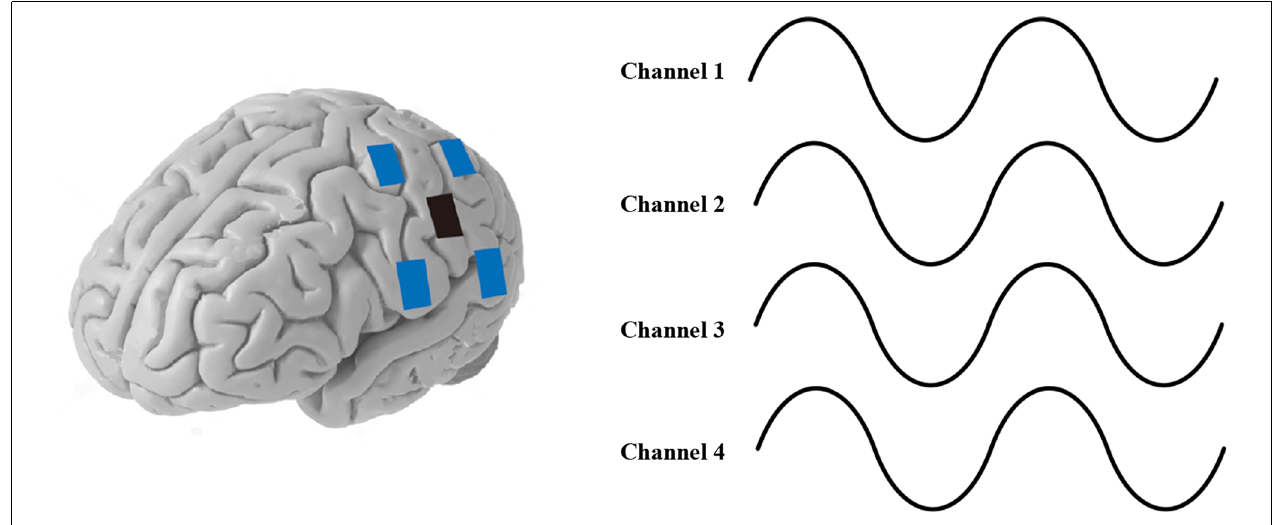
FIGURE 2 | Schematic diagram of